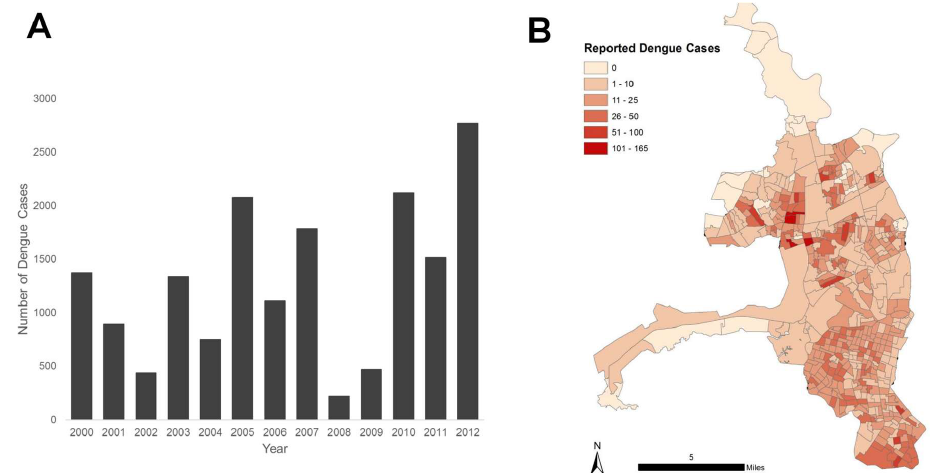
Figure 1. Annual number of reported cases of dengue fever in Guayaquil, Ecuador (2000–2012) ( A ). Cases of dengue fever per census zone in Guayaquil during the 2012 outbreak ( B ).